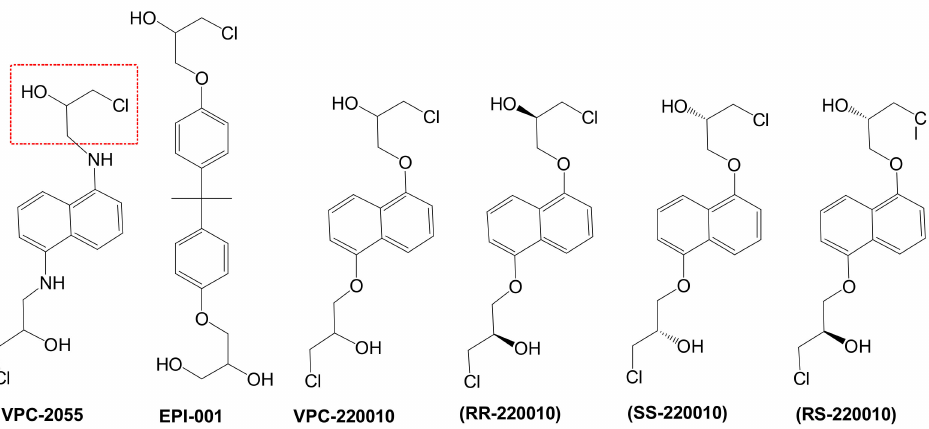
Figure 1. The chemical structures of VPC-2055, EPI-001, VPC-220010 and its enantiomers (RR-220010, SS-220010,